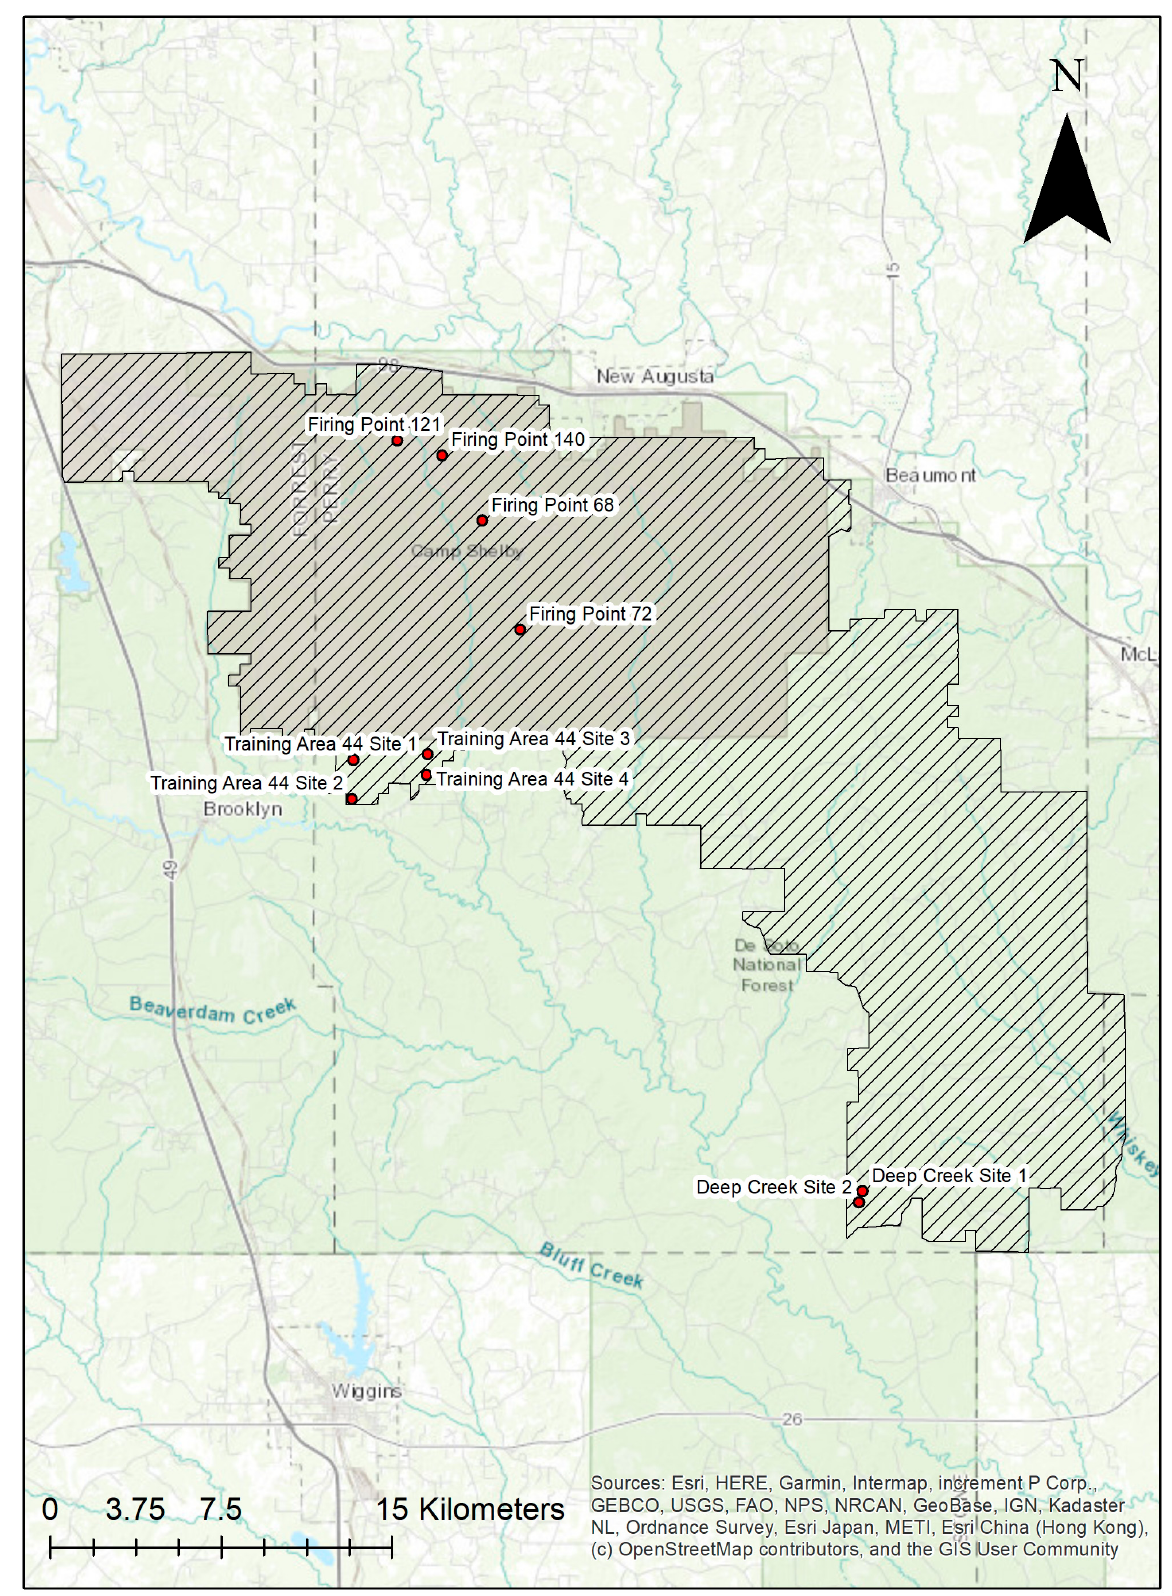
Figure 1. Map of Camp Shelby Joint Forces Training Center (CSJFTC). Study sites are labelled points.